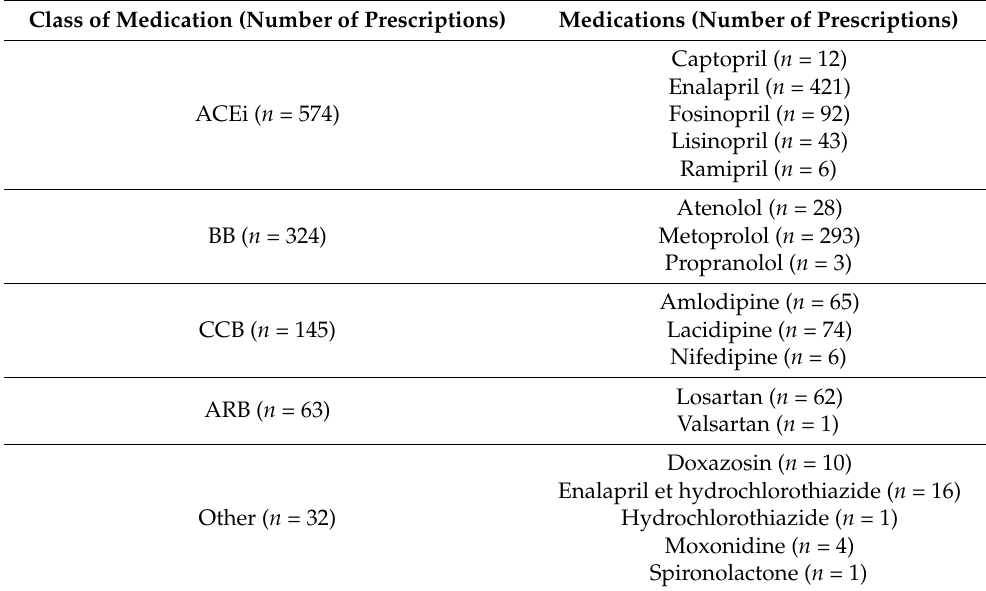
Table 2. Rates of different class antihypertensive medication prescription by age and AH etiology. Class of Medication (Number of Prescriptions) Medications (Number of Prescriptions)